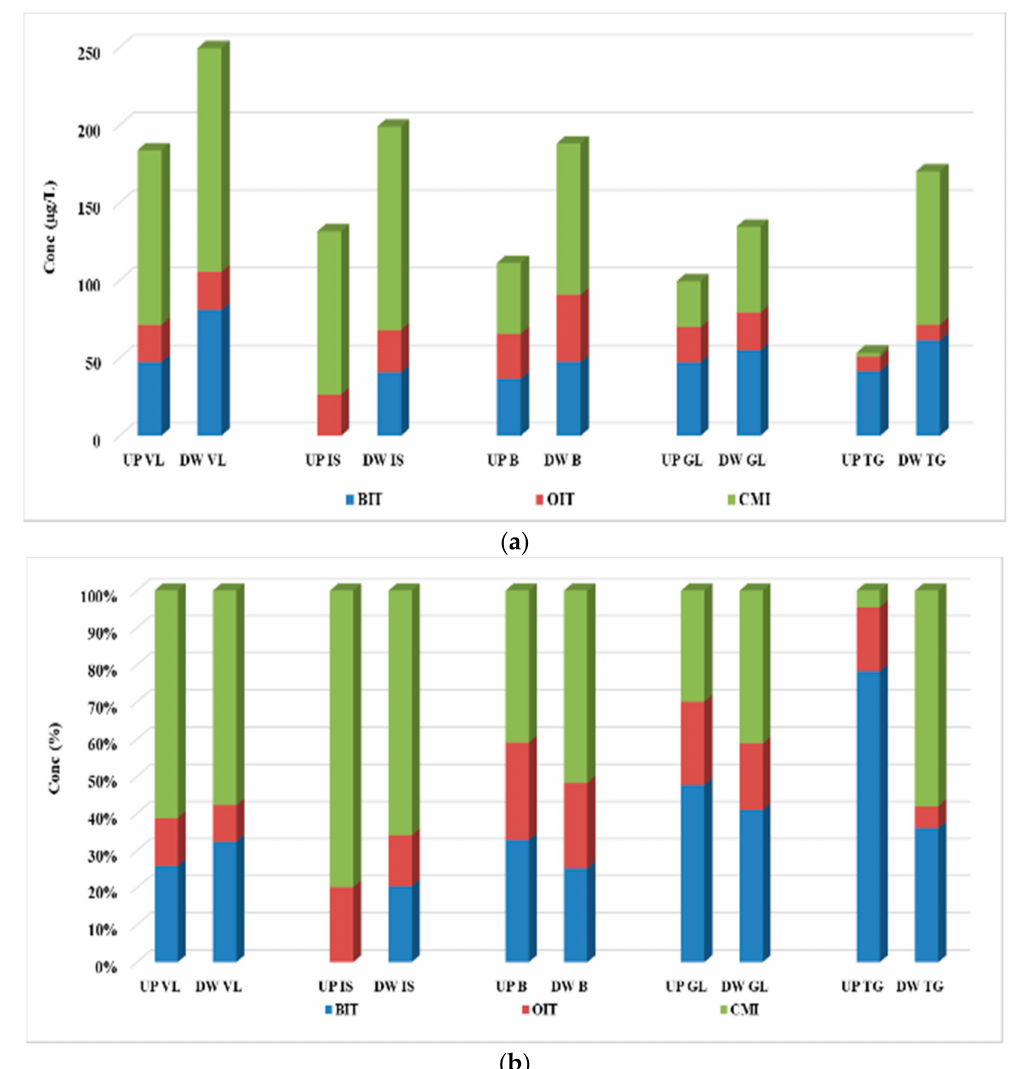
Figure 5. Variation ( a ) and distribution pattern ( b ) of the four target biocides in surface water samples. Downstream from the WWTPs, CMI and BIT were detected at higher concentration than OIT, with their maximum concentrations at 144 µ g/L and 81.1 µ g/L,